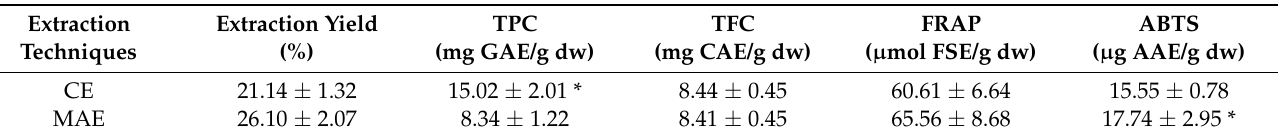
Table 1. Extraction yield, total phenolic and flavonoid contents (TPC and TFC, respectively), and in vitro antioxi- dant/antiradical activities (evaluated by FRAP, ABTS and DPPH assays) of S. ramosissima extracts prepared by conventional and microwave-assisted extraction (CE and MAE, respectively). Values are expressed as mean ± standard deviation ( n = 3).